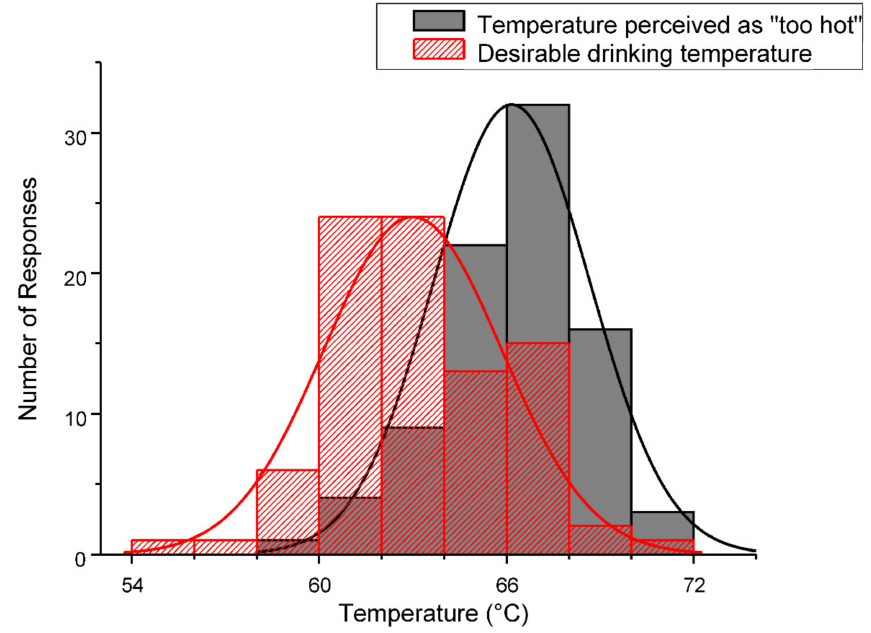
Figure 2. Histogram of the distributions for temperatures perceived as “too hot” and as “desirable/preferred” ( n = 87). The curves show the normal distribution for both data